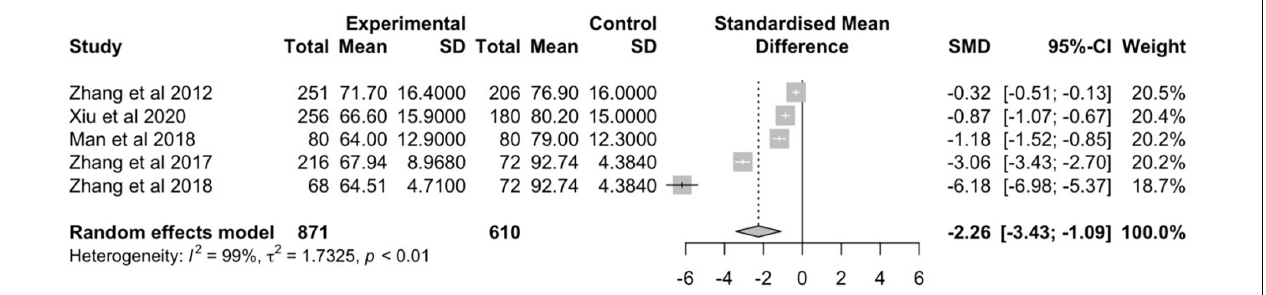
FIGURE 4 | Forest plot of standardized mean difference (SMD) in total mean RBANS scores measured in patients with schizophrenia and healthy